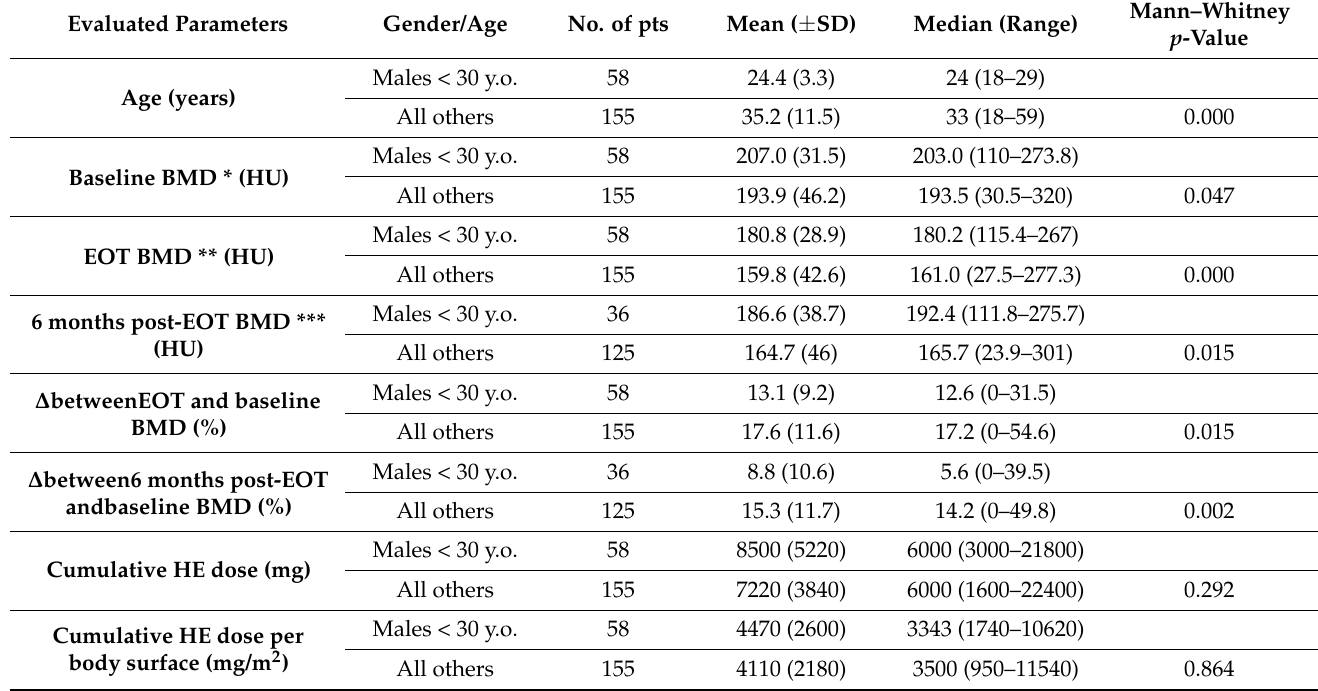
Table 5. BMD changes in male patients younger than 30 years compared to all other